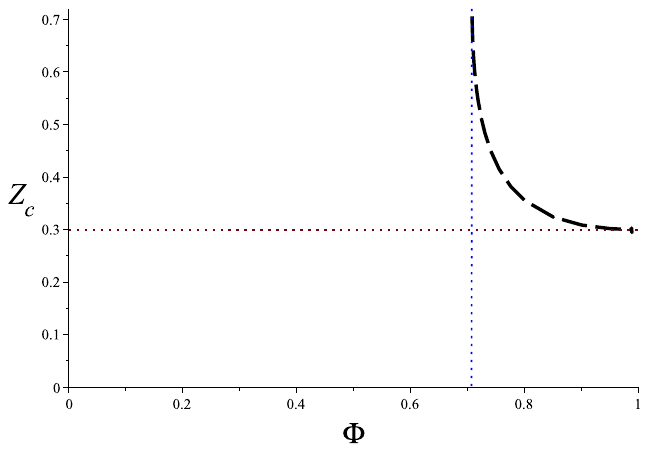
Figure 20 . Critical compressibility factor Z c (cid:17) P c v c vs the conjugate potential (dashed line), in T c the window for criticality, 1 p < (cid:8) < 1. It is observed that 0 : 3 . Z c < 1 . In the plot, the vertical 2 p dotted line is (cid:8) = 1 = 2, and the horizontal one to the limit Z c (cid:25) 0 :